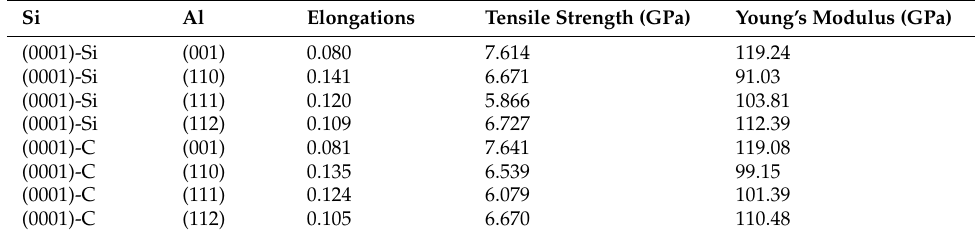
Figure 2. Engineering stress–strain curves of eight interface model systems under tensile loading. Table 4. Comparisons of the elongations, tensile strength, and Young’s modulus of eight SiC(0001)/Al models. Si Al